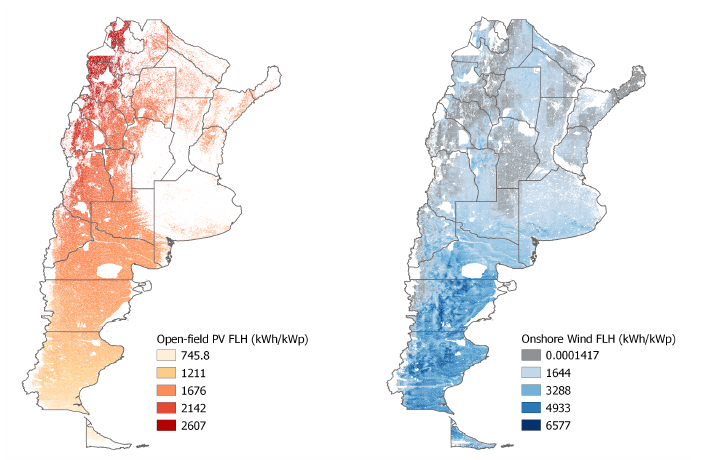
Figure 4. Exemplary full load hour maps of Argentina GID-1 level for open-field PV and onshore wind.